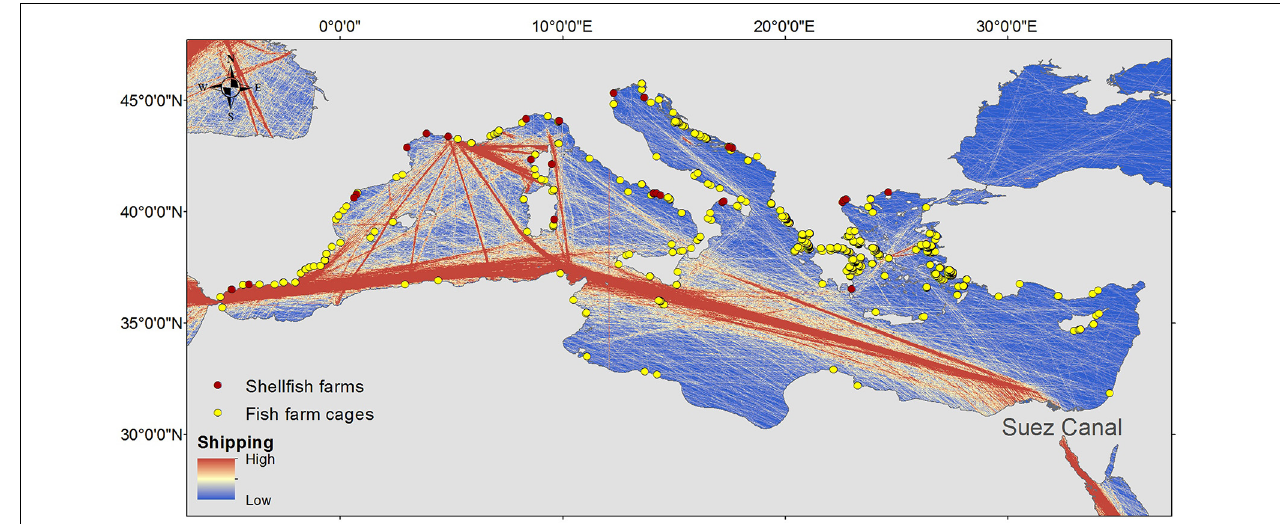
FIGURE 1 | The human activities/interventions mostly responsible for marine biological invasions in the Mediterranean Sea: (1) the opening of the Suez Canal connecting the Red Sea and the Mediterranean; (2) shipping (the color of the marine area